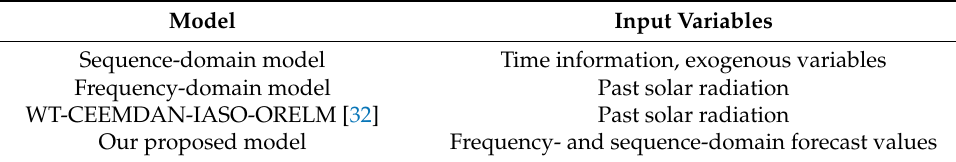
Table 4. Input variables used for each